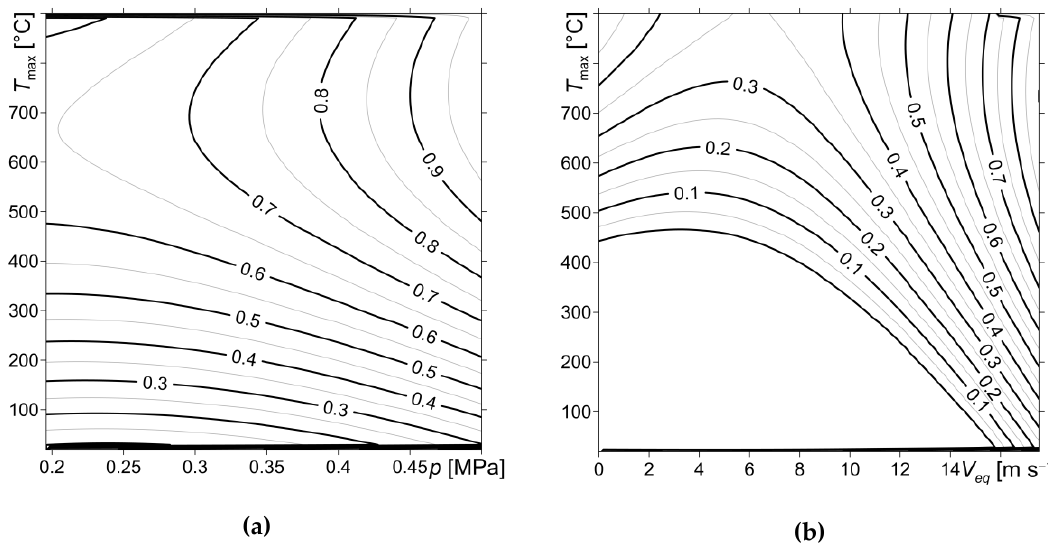
Figure 8. Isolines of the coefficient of friction f (variant 1): ( a ) in coordinate system ( p , T max ) at V eq = 17.531 m·s −1 ; ( b ) in coordinate system ( V eq , T max ) at p = 0.45 MPa.